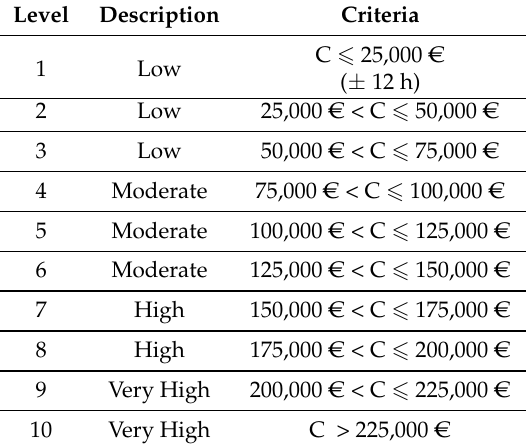
Table 4. Evaluation criteria to assess delay